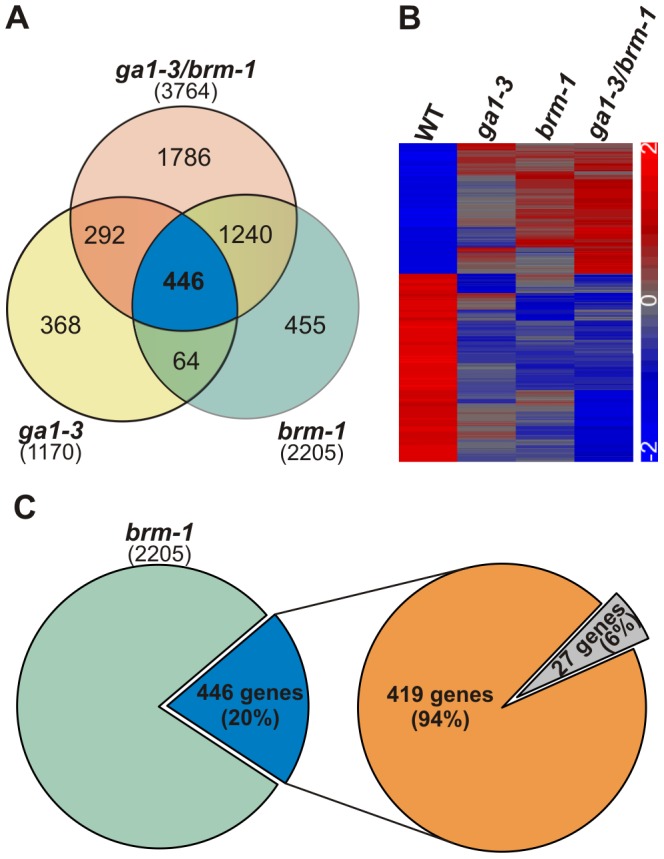
Transcriptional profile of brm-1 overlaps with that of ga1-3.(A), Overlap between differentially regulated genes in mutants brm-1, ga1-3 and ga1-3/brm-1 identified in microarray data, shown by a Venn diagram. (B), Genes up- and down-regulated in all three mutants, shown by a heat map. The color scale represents normalized expression levels. (C), 94% of the genes commonly mis-expressed in all three mutants show expression changes in a similar direction. Green – genes mis-regulated only in brm-1; blue – genes mis-regulated in brm-1, ga1-3 and ga1-3/brm-1; orange – genes mis-regulated in a similar direction in all three mutants; gray – genes mis-regulated in an opposite direction in one of the mutants.